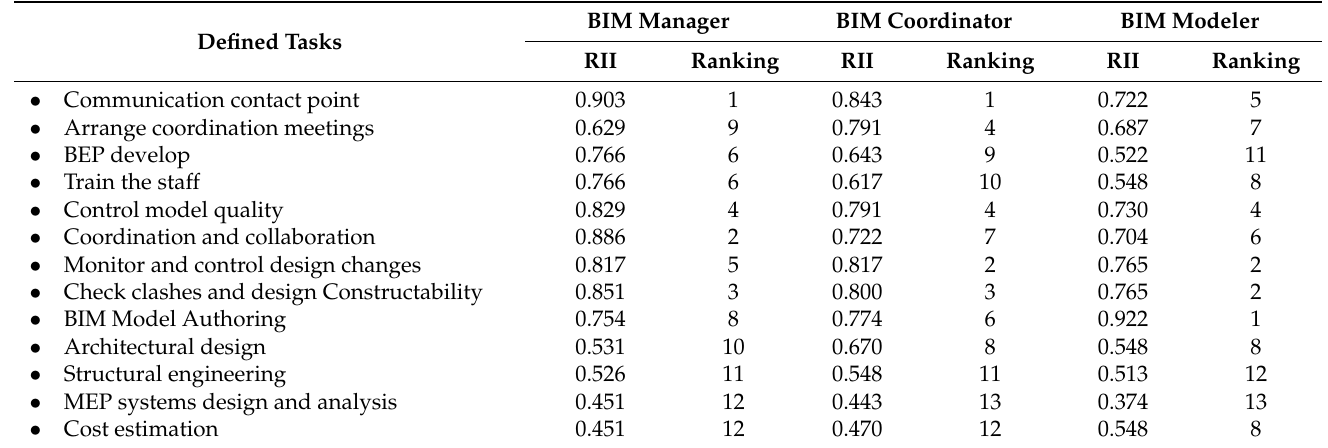
Table 3. The performance frequency of BIM-related tasks, ranked by questionnaire participants. Defined